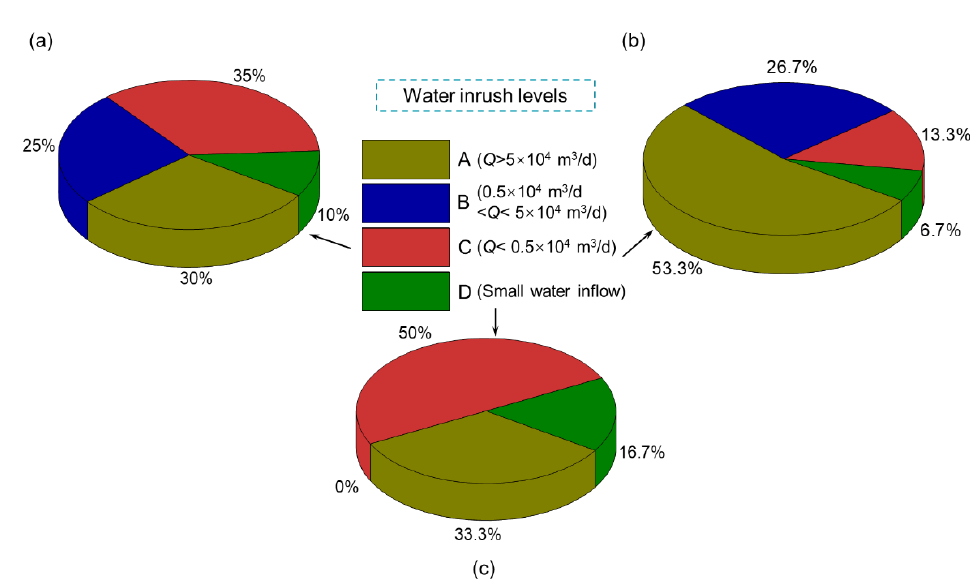
Figure 8. Proportion of water inrush from each unfavorable geology type in tunnels.